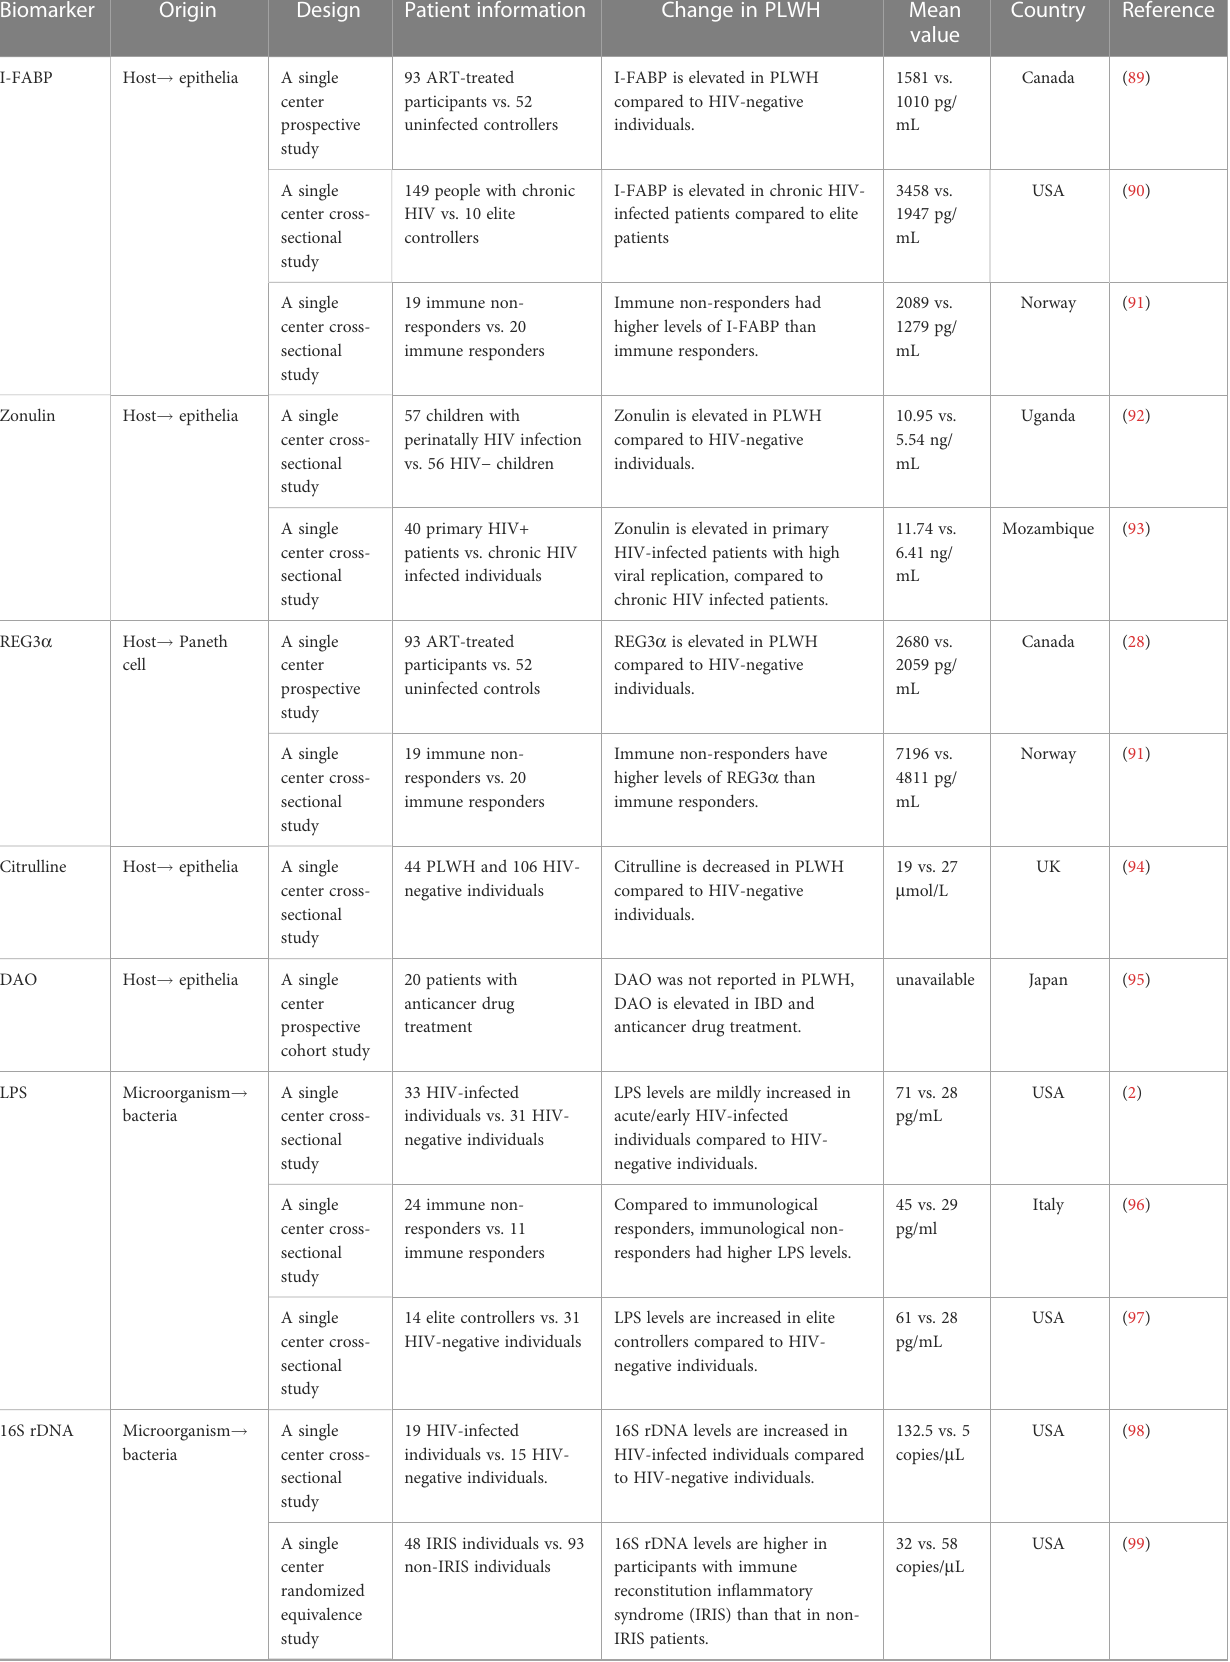
TABLE 1 Biomarkers for gut damage and microbial translocation in